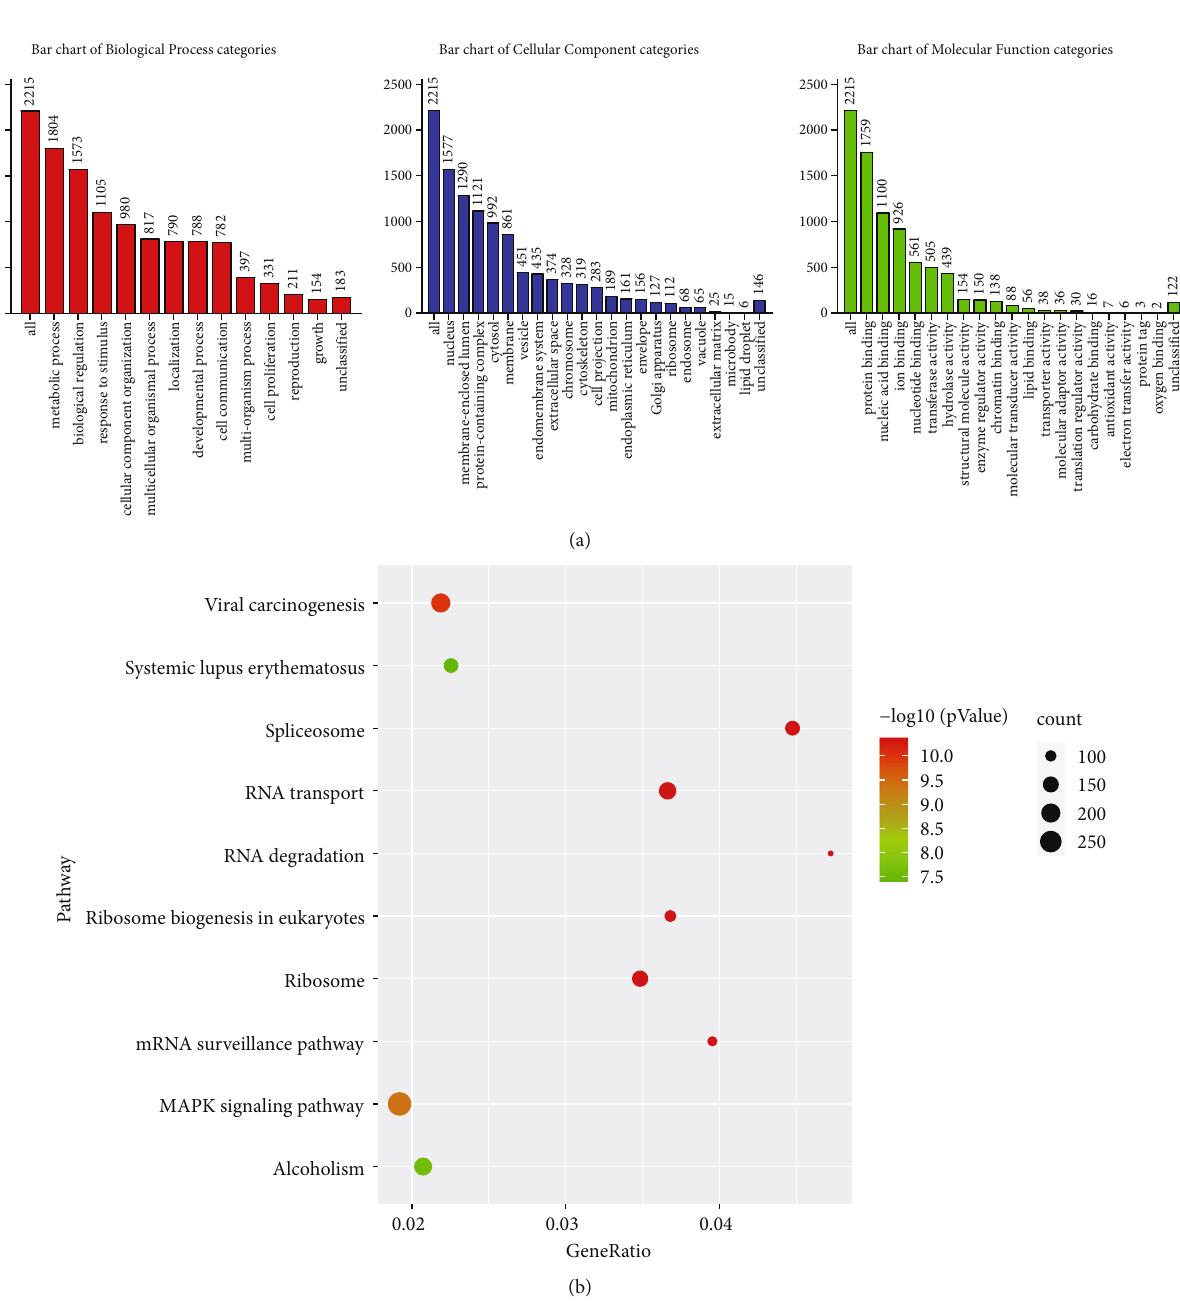
Figure 2: GO functional and KEGG pathway analyses. (a) Summary of the DEG and GO pathway enrichment. Red, blue, and green bars represent the biological process, cellular component, and molecular function categories, respectively. The height of the bar represents the number of DEGs observed in each category. (b) The top 10 pathways of the LLPS genes associated with the OS of HCC